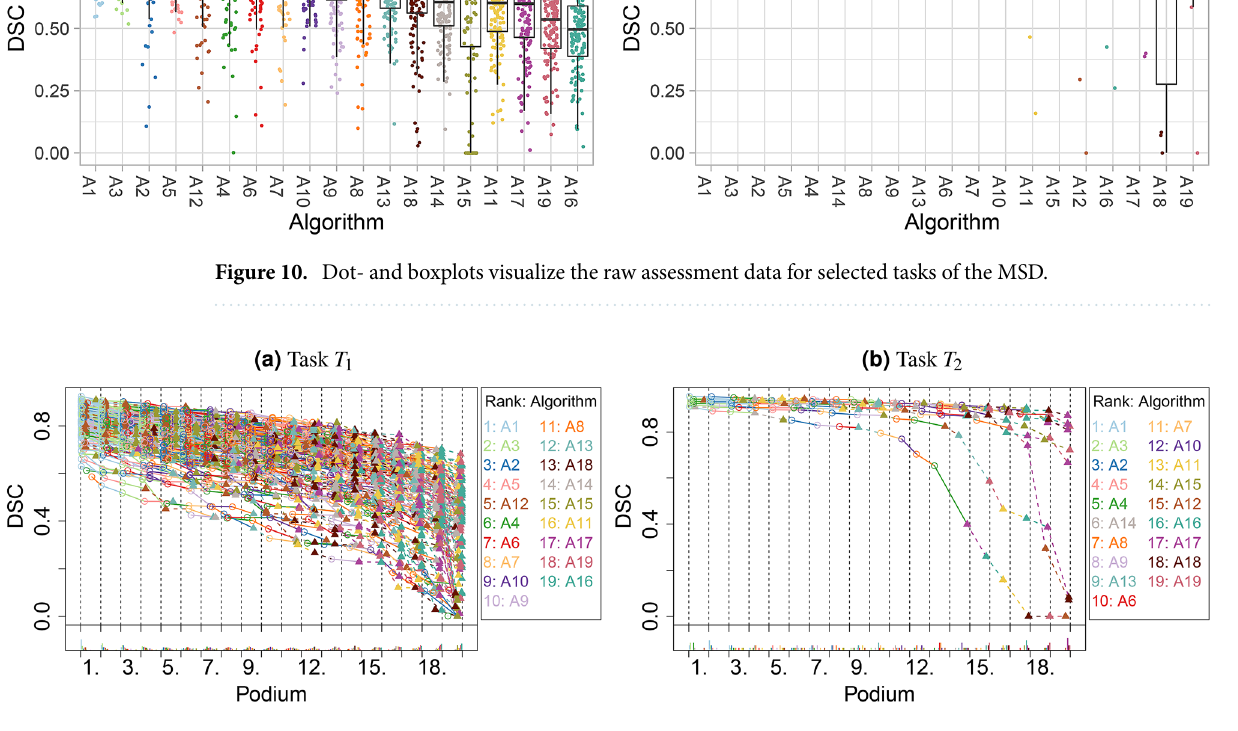
Figure 11. Podium plots visualize the assessment data for selected tasks of the MSD. T 1 / T 2 : task with stable/ unstable ranking. In addition to the color scheme, algorithms A1–A10 are marked with circles and solid lines and algorithms A11–A19 with triangles and dashed